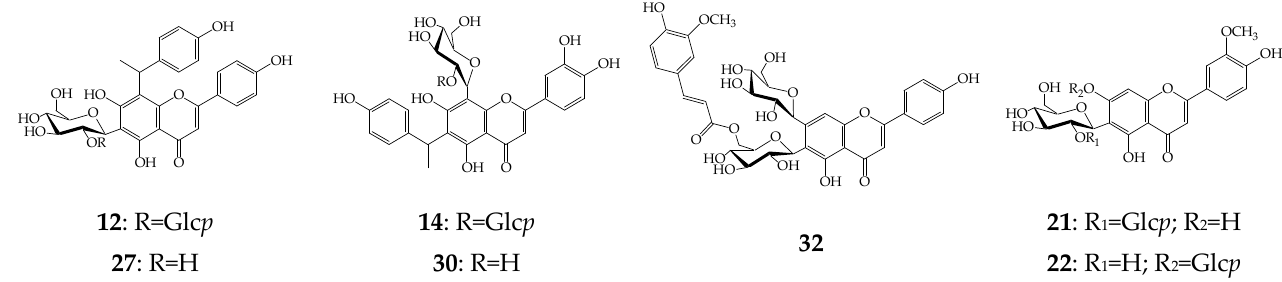
Figure 4. Known apigenin and chrysoeriol glycosides found in cucumber fl owers. Glc p —glucopy- ranose.